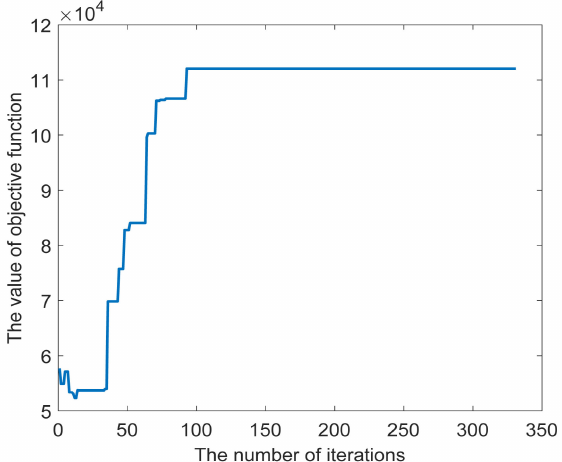
Figure 5. The convergence curve of the small-scale